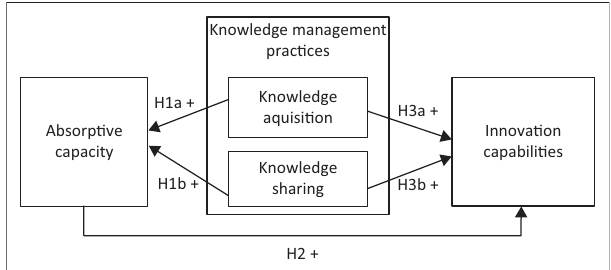
FIGURE 1: Research model.